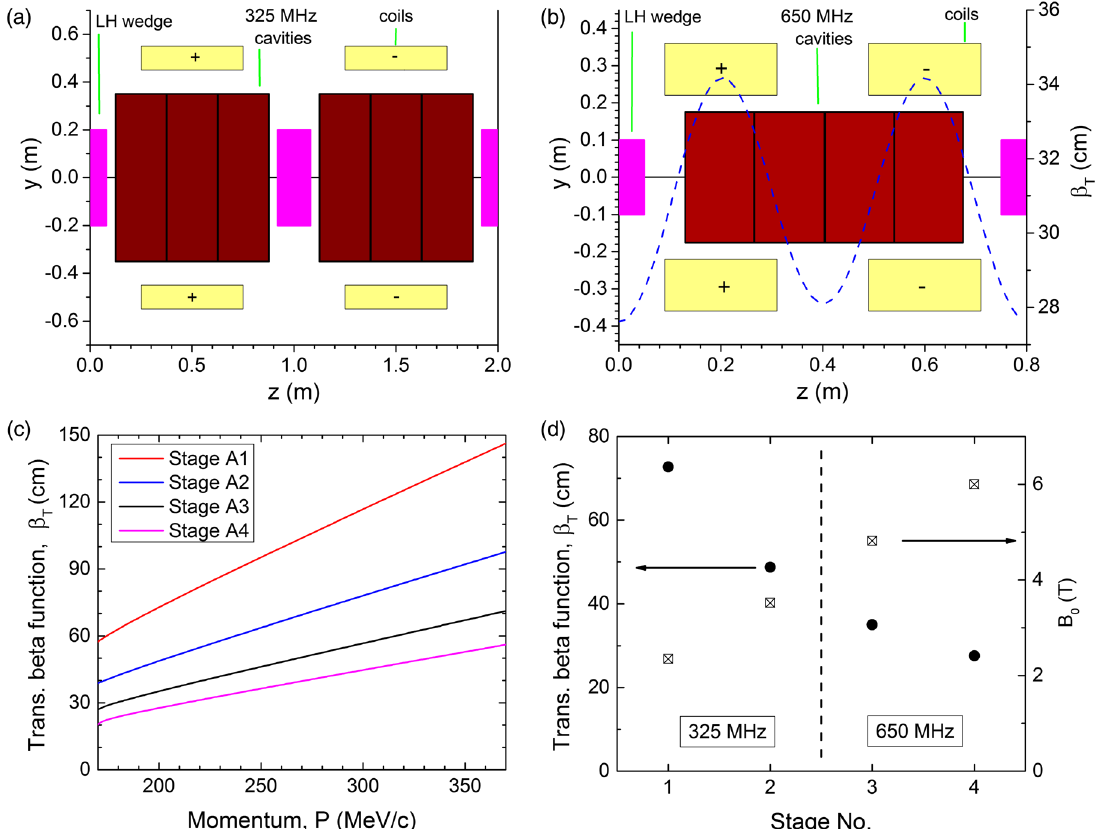
FIG. 4. Lattice characteristics of the rectilinear 6D cooling channel before bunch recombination: (a) side view of one cell of the first stage (stage A1); (b) side view of one cell of the last stage (stage A4). The dashed curve shows the beta function versus z in the cell at 200 MeV =c ; (c) beta function versus momentum; (d) beta function at the absorber center (dark circles) at 200 MeV =c and peak-on-axis magnetic field (squares) for all stages. The tilts of solenoids are not